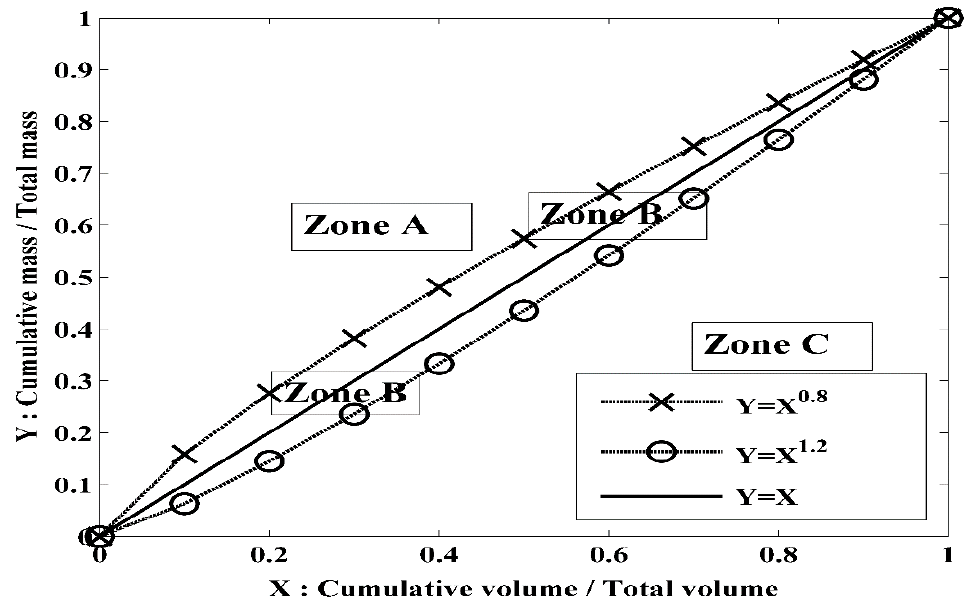
Figure 2. Definition of the M (V) curve zones.